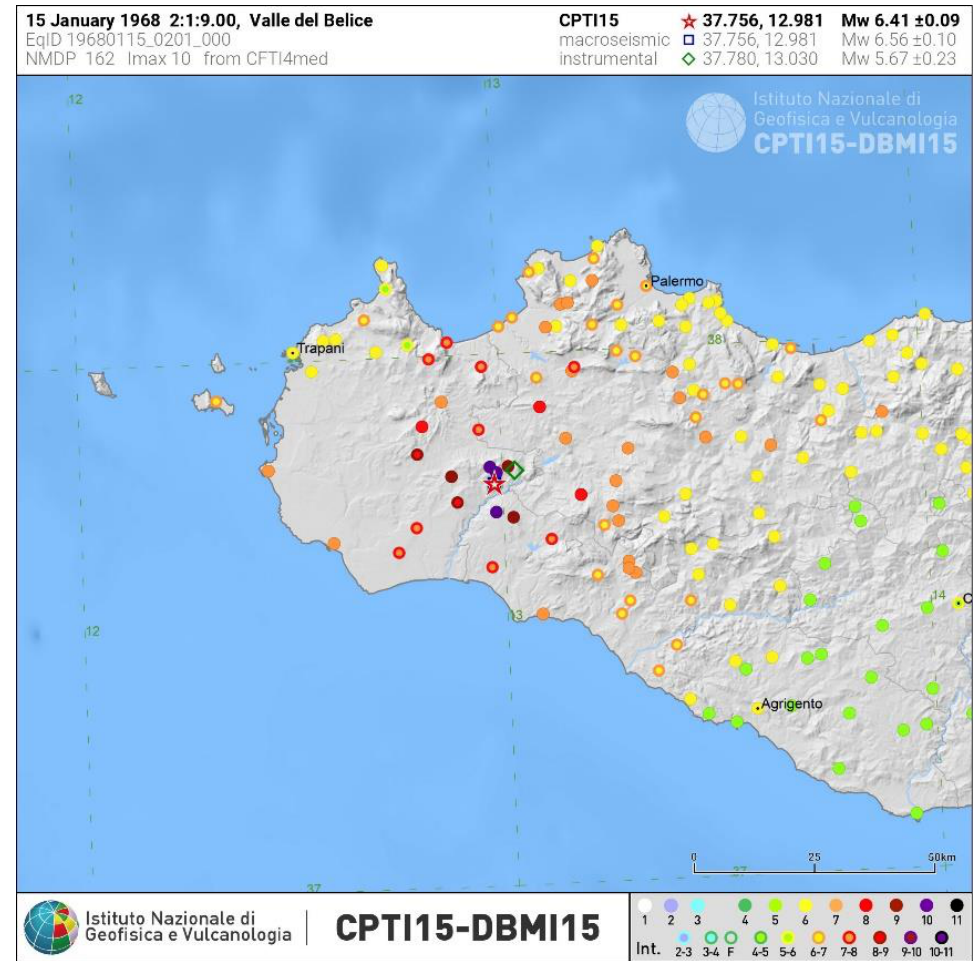
Figure 4. Seismic intensity map of 15 January 1968 Belìce earthquake from INGV CPTI (Catalogo Parametrico dei Terremoti Italiani) ver. 4.0 [21 – 23].